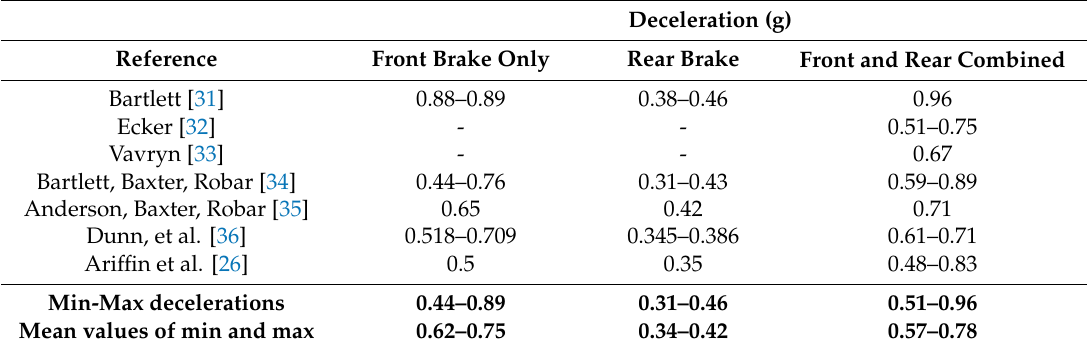
Table 2. Braking deceleration rates in g reported in the literature (dry and wet